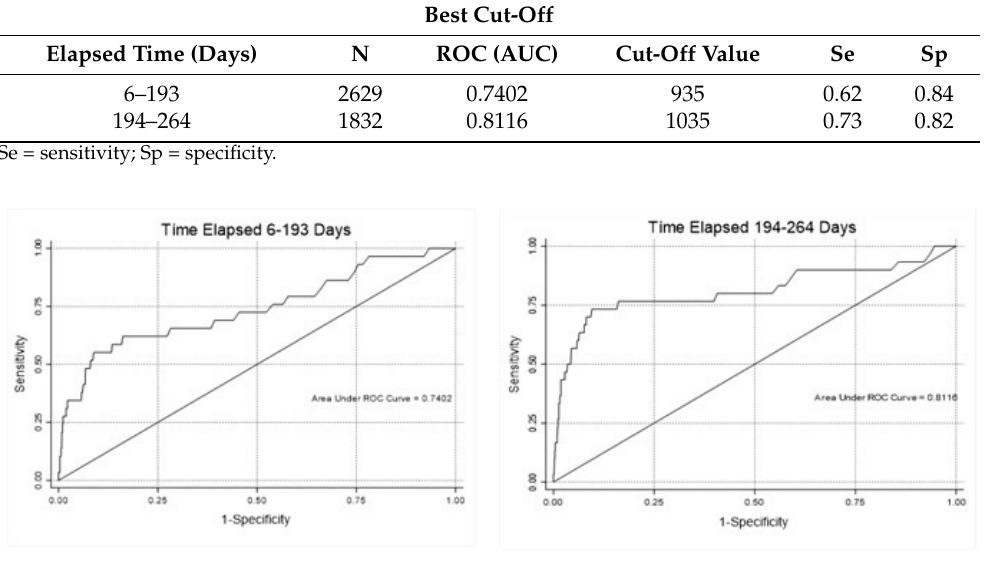
Figure 2. Discriminant power of antibody-S IgG titer evaluated by area under the ROC curve (ROC-AUC), as a function of time elapsed since second vaccination dose.